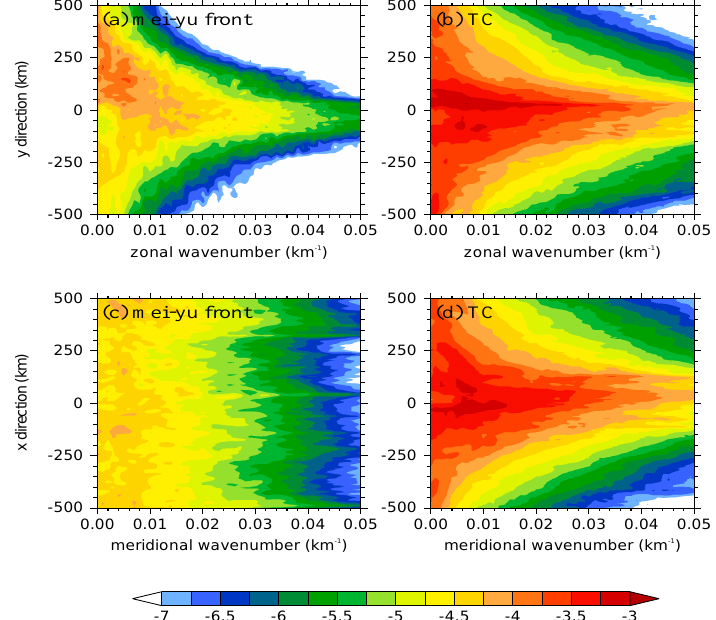
Figure 3. Base-10 logarithm of PSDs of w GW (shaded; m 2 s –2 ) as a function of ( a , b ) zonal wavenumber and y direction, and ( c , d ) meridional wavenumber and x direction at z = 17 km, for ( a , c ) the mei-yu front and ( b , d ) the